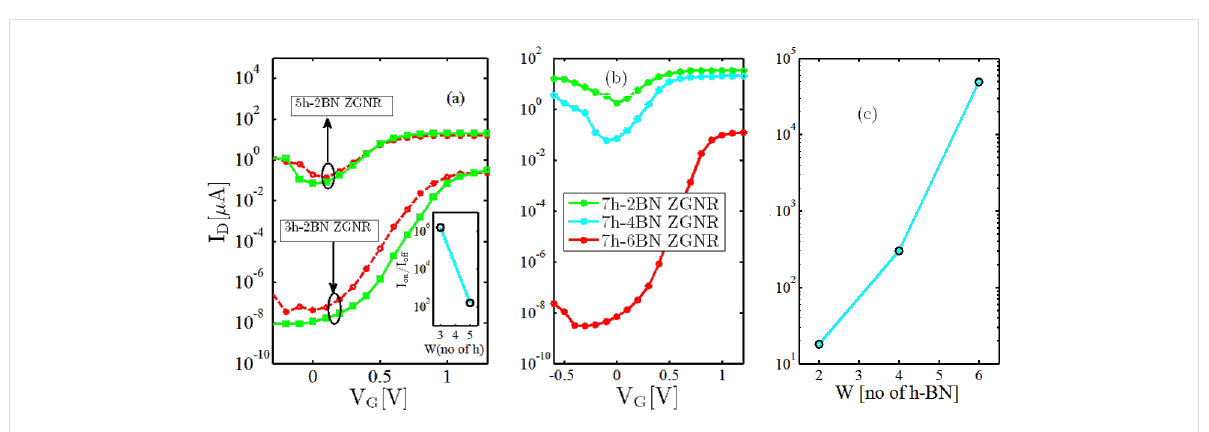
Figure 5: (a) The average transfer characteristic of 10 nm length devices with SiO 2 substrate for different device widths but the same BN widths (3h- 2BN and 5h-2BN) with (red) and without (green) SR. The inset shows the on-/off-current ratio of rough devices with respect to device width. (b) The average transfer characteristic and (c) the on-/off-current ratio of a 2.84 × 10 nm 2 device (7h) with SiO 2 substrate for various BN widths.